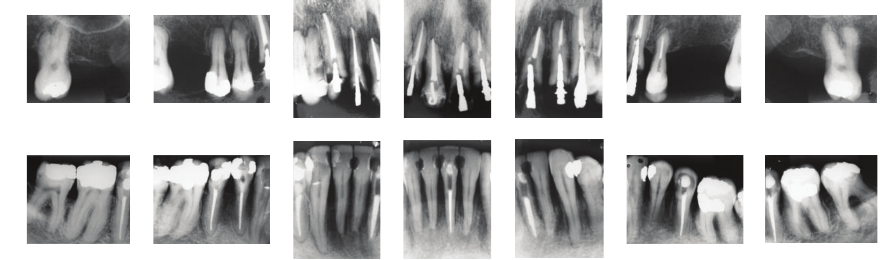
Figure 6: Posttreatment periapical radiographs.